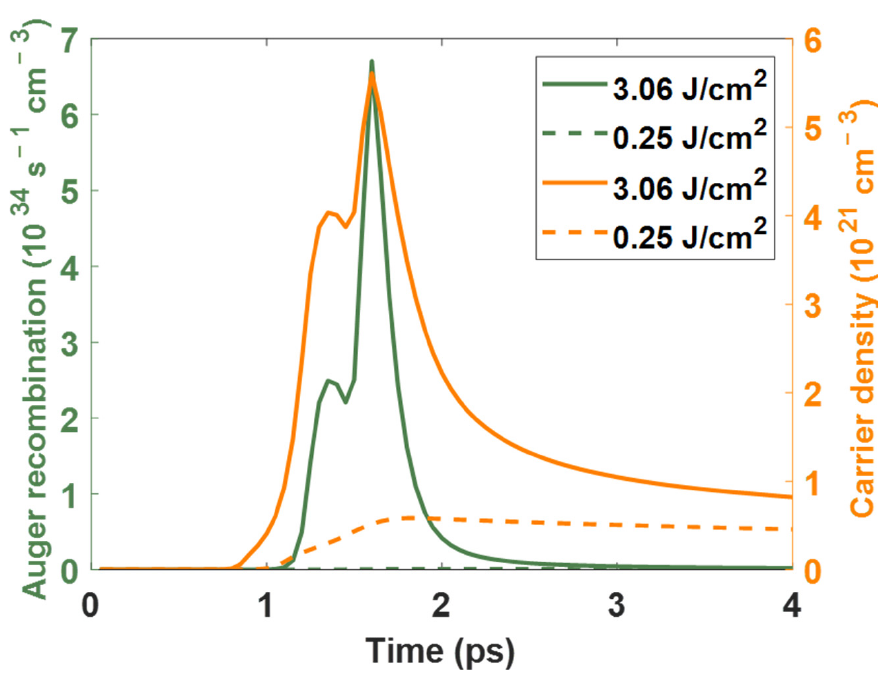
Figure 8. The temporal Auger recombination e ff ect and carrier density calculated with 0.25 and 3.06 J/cm 2 fl uences.